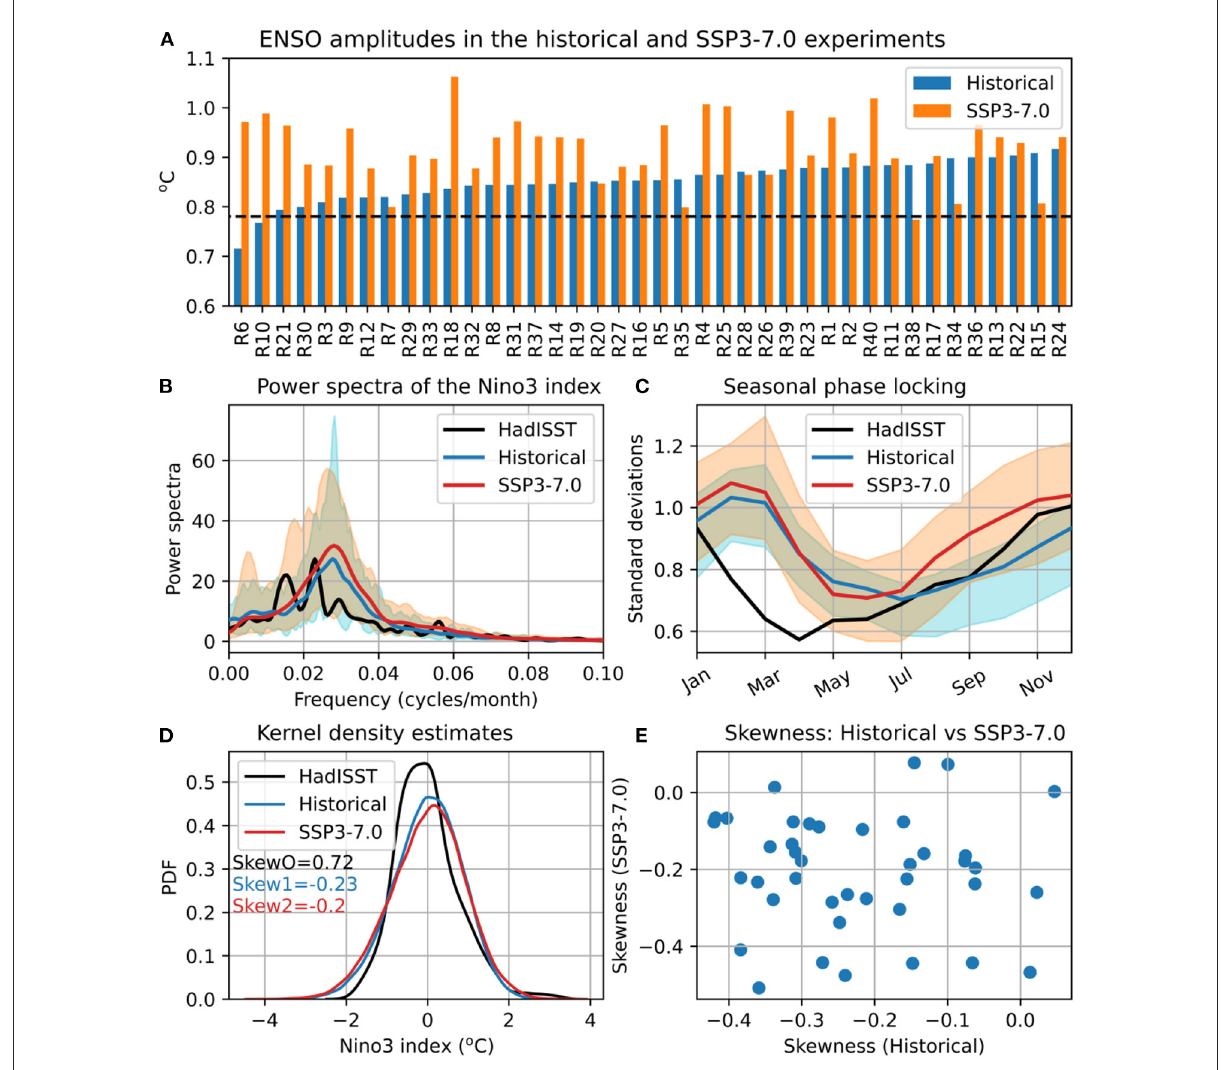
FIGURE2 Selected ENSO properties and their changes under global warming as estimated from ACCESS-ESM1.5 large ensembles. (A) ENSO amplitudes (standard deviations of the Niño-3 index) for individual ensemble members of the historical and SSP3-7.0 experiments; the horizontal dashed line indicates the observed amplitude; (B) power spectra; (C) annual variation of ENSO amplitudes; (D) probability density functions; and (E) skewness. The ENSO properties were calculated using the Niño-3 indices from observations (black curve) and the ACCESS-ESM1.5 large ensembles (colored curves). The plotting conventions are as in Figure